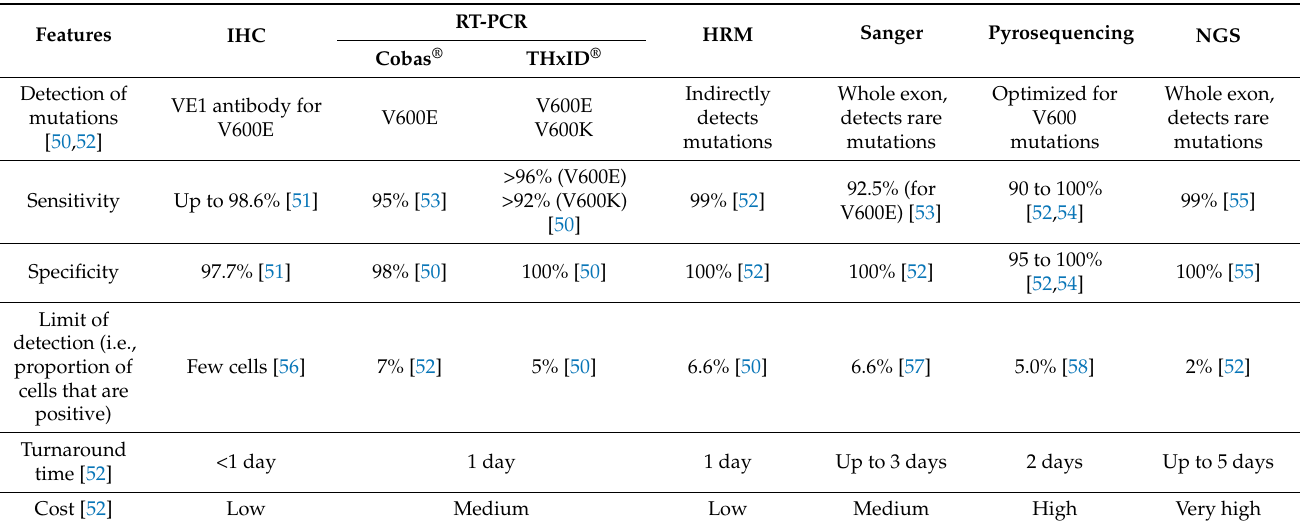
Table 2. Summary of diagnostic testing modalities used to detect BRAF -mutated melanoma. IHC, immunohistochemistry; HRM, high-resolution melt; NGS, next-generation sequencing; RT-PCR, real-time polymerized chain